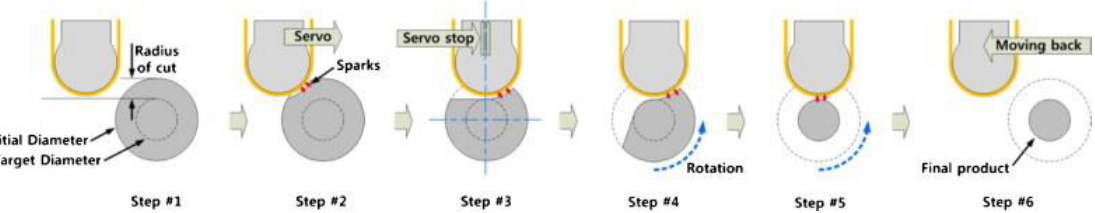
Figure 17. Strip-EDM turning process [166].